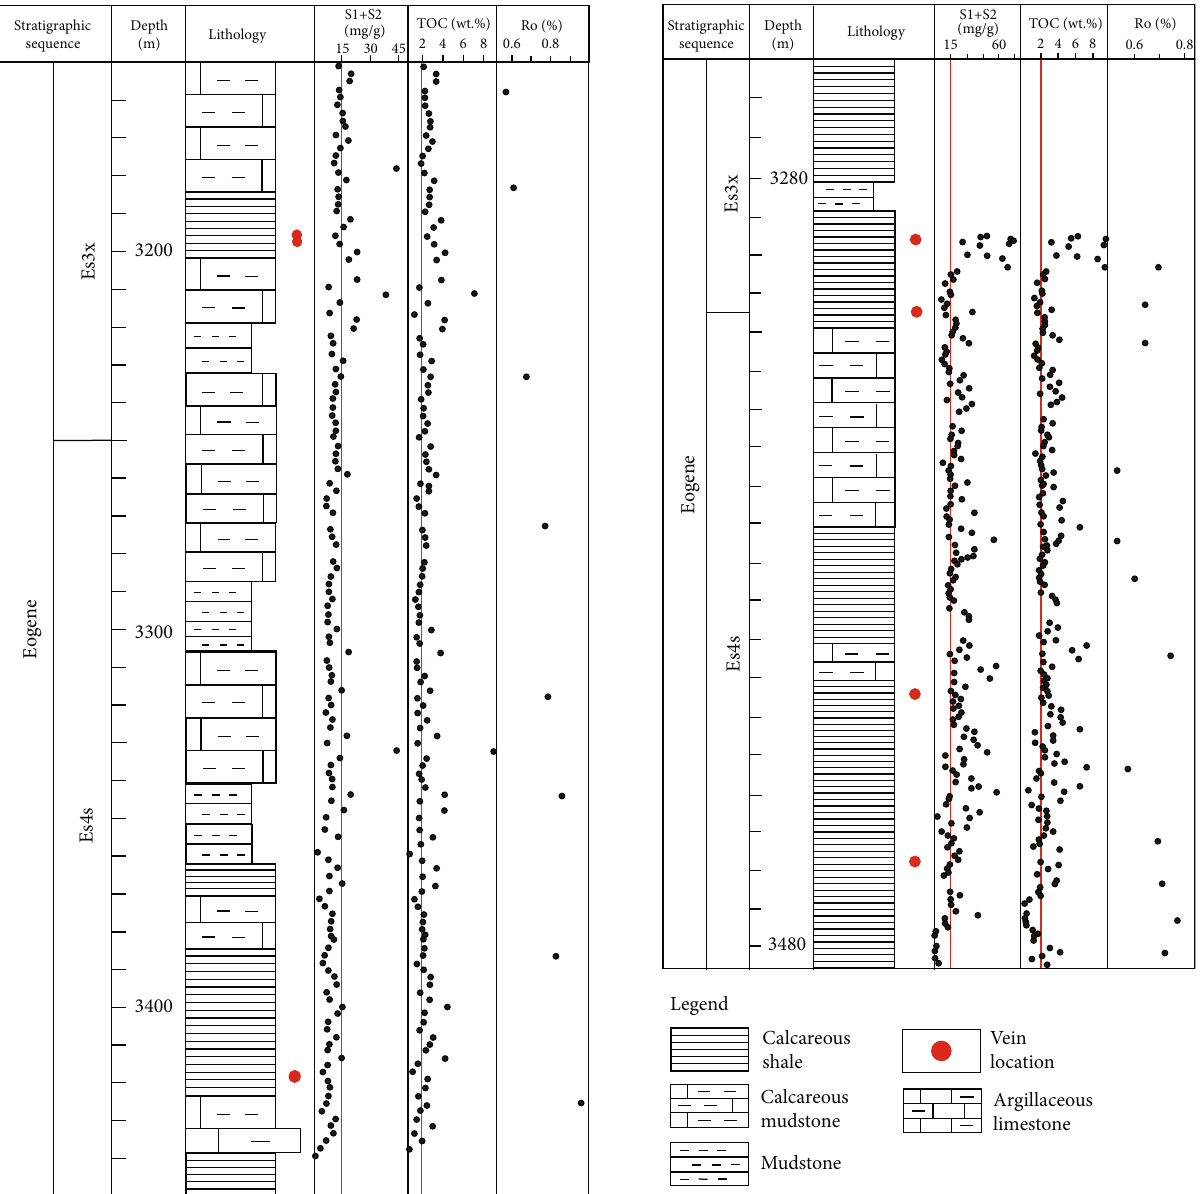
Figure 10: Location lithology and geochemical characteristics of samples FY1 and